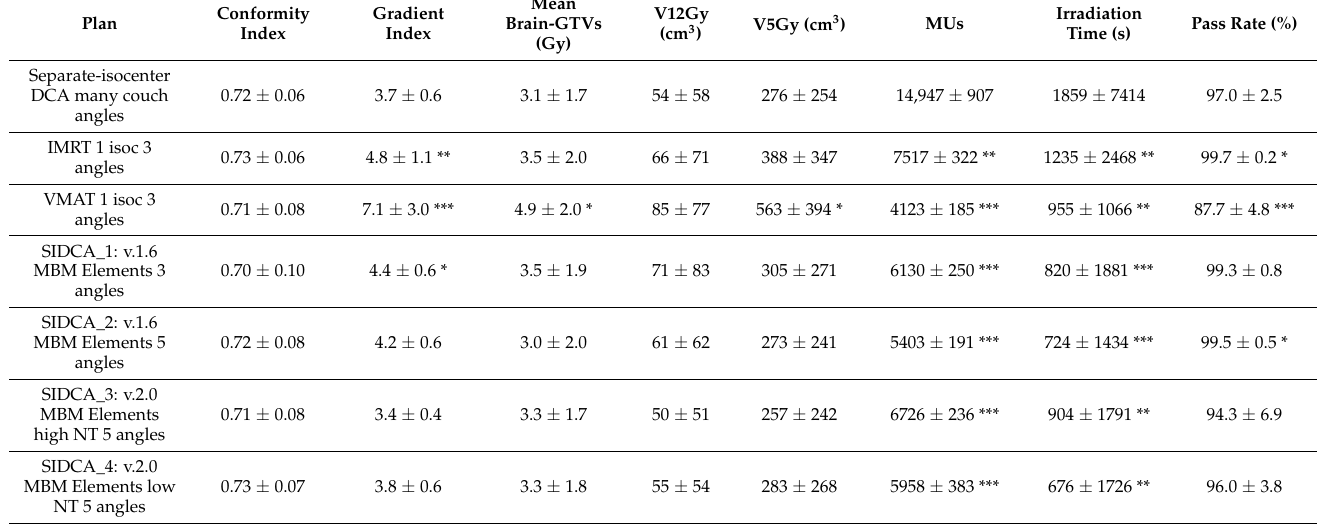
Table 2. Conformity Index (CI), Gradient Index (GI), mean dose, total V 12Gy and V 5Gy of the uninvolved brain, i.e., brain volume—GTVs, number of monitor units (MUs), irradiation time and pass rate (3%/3 mm) as mean ± 1SD. The planning techniques, which were significantly different from separate-isocenter (reference) planning depending on the p -value, are shown with one, two, or three stars, corresponding to levels equal to or below 0.05, 0.01, and 0.001,